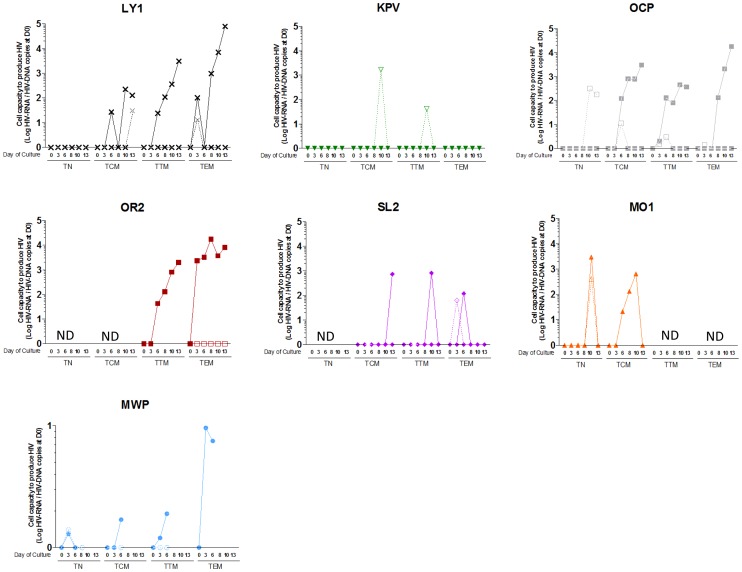
HIV replication is inducible from the resting memory CD4 T cell subsets from post-treatment controllers.The cell capacity to replicate HIV was evaluated in 7 PTCs (each symbol represents one PTC) by stimulating sorted-CD4 T cell subsets with an anti-CD3/anti-CD28 co-stimulation plus IL-2 and IL-7 (filled symbols and continuous lines) or IL-7 alone (empty symbols and dashed lines). HIV RNA was quantified in the supernatants of resting TN, TCM, TTM and TEM cells during a 13-day long culture. Results are expressed as the log10 of the ratio between the HIV RNA copy numbers quantified at a given day of culture and the level of cell-associated HIV DNA in the subset measured at D0 of culture. Kinetics of HIV production in a patient has been represented with connecting lines. HIV RNA values that were under the detection threshold of the technique were arbitrarily placed at 0. ND is not done.